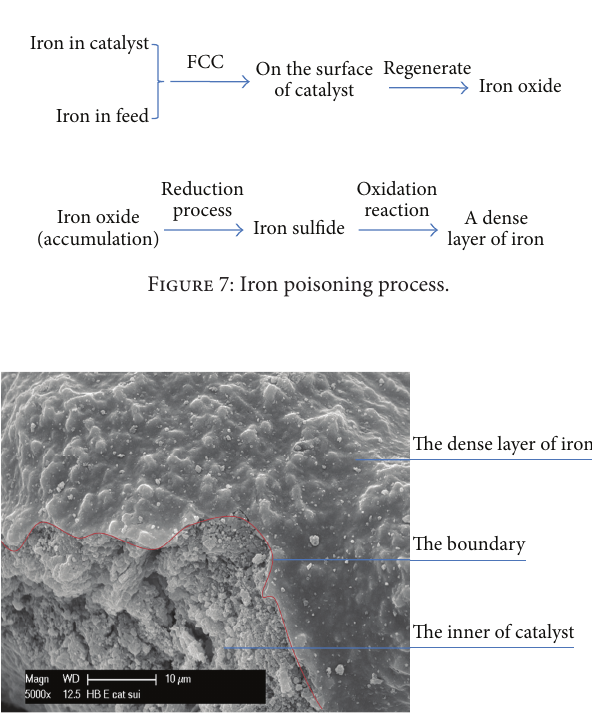
Figure 8: SEM image of E-catalyst with high iron